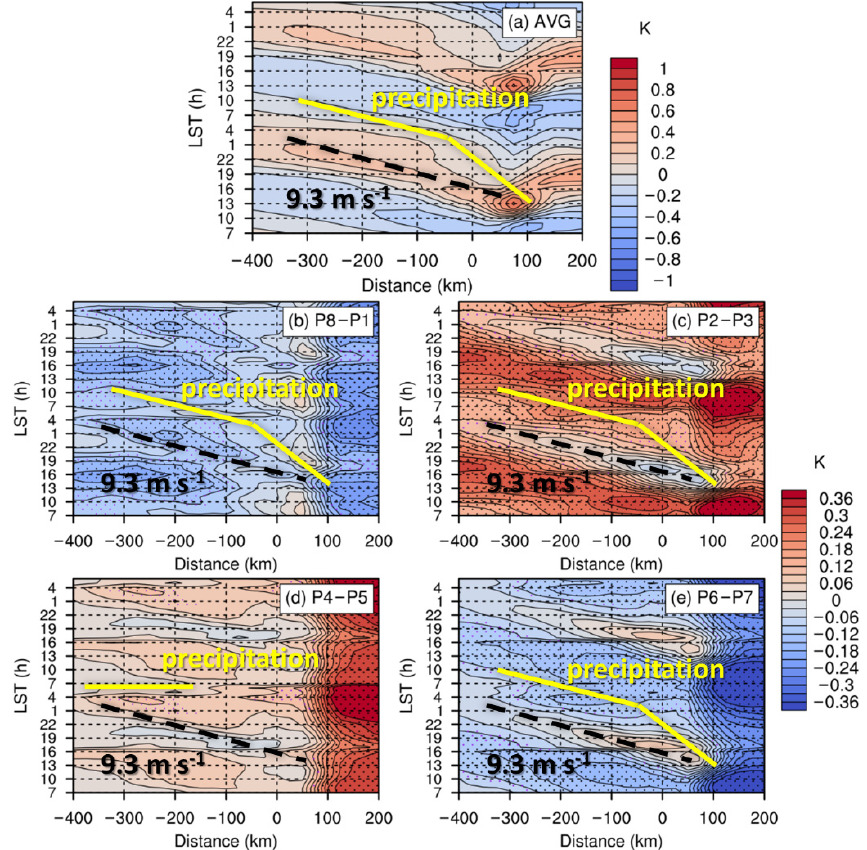
Figure 12. The Hovmöller diagrams of temperature difference (K) between 850 hPa and 600 hPa ( a ) averaged in DJF 2011–2020 with daily mean subtracted, as well as its anomaly in ( b ) P8–P1, ( c ) P2–P3, ( d ) P4–P5 and ( e ) P6–P7. The black dashed lines mark the daily maximum of temperature difference in ( a ). The yellow solid lines mark the diurnal maximum of precipitation as indicated in Figure 3. The purple and black dots indicate the 90% and 95% confidence according to the Student’s t -test.